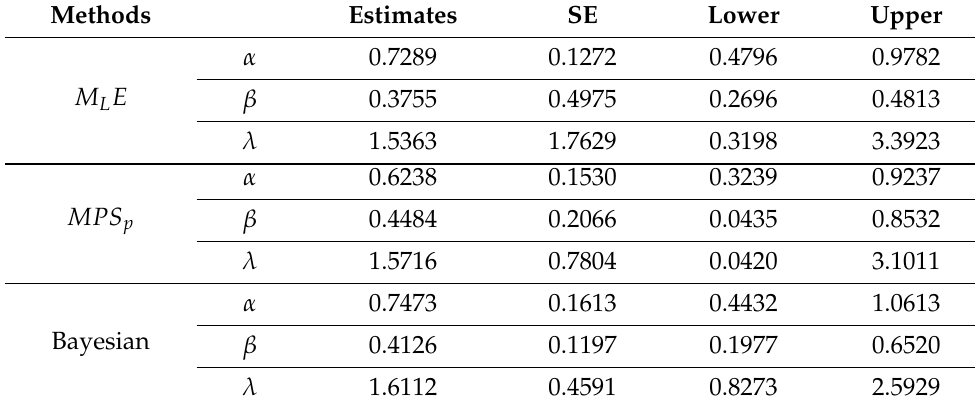
Table 12. M L E , MPS p , Bayesian estimation methods for failures of 20 components